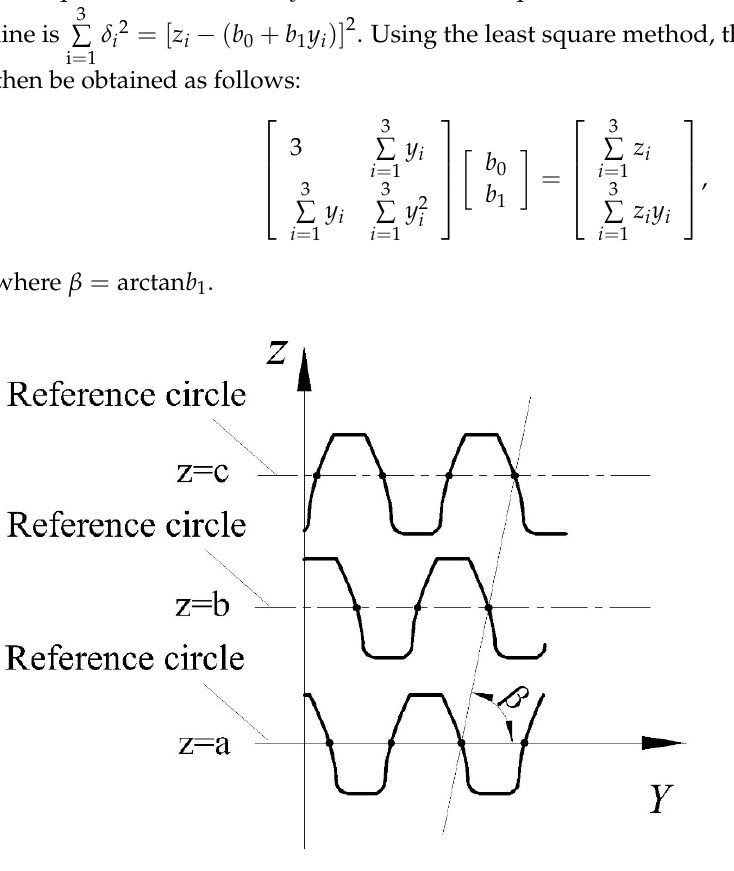
Figure 6. Schematic diagram of helix angle analysis.